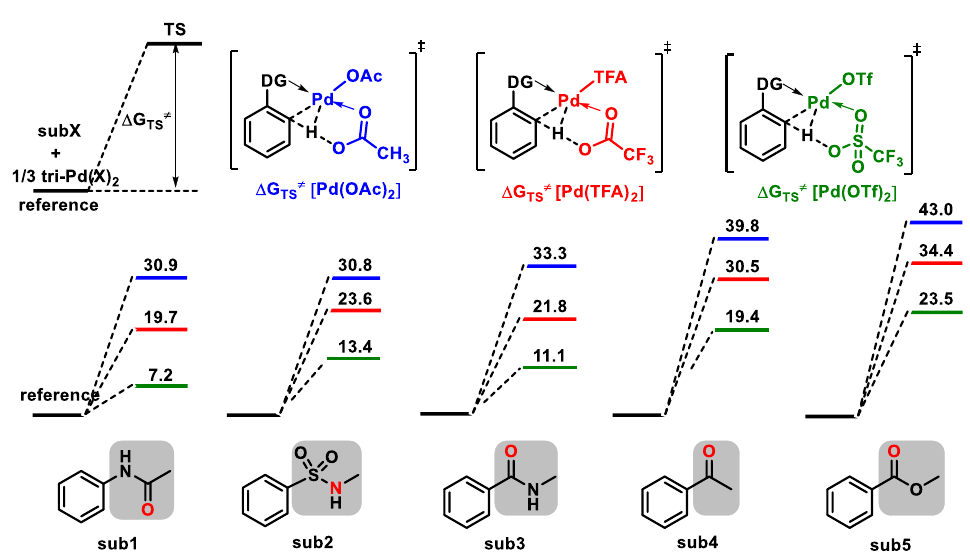
Figure 1. Calculated activation free energies by CMD mechanism (ΔG TS ≠ , kcal/mol) for the five substrates with three different Pd catalysts. The coordination atoms are marked in red.